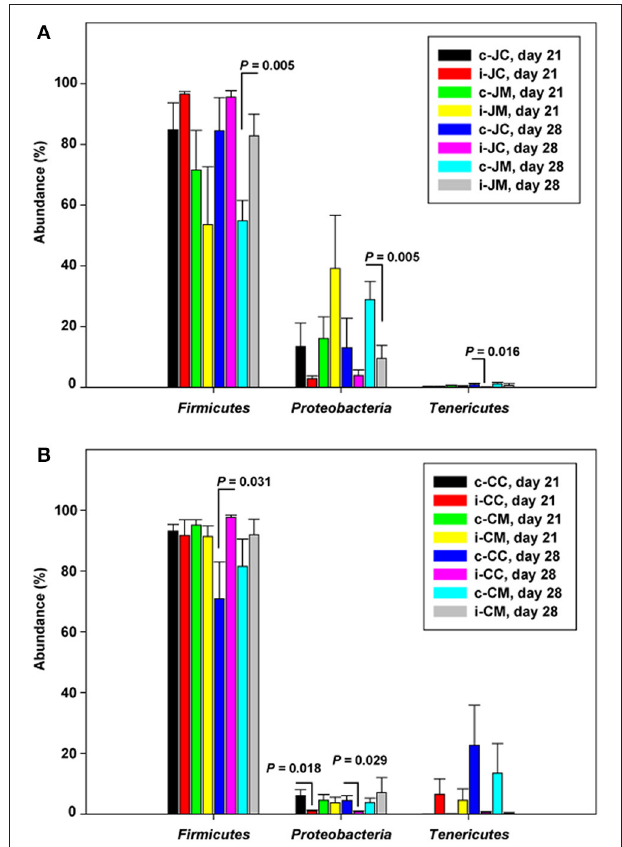
FIGURE 1 | Relative abundances (%) of the most abundant phyla in the infected birds compared with the controls at the two sampling points post infection of (A) jejunum and (B) cecum. Data are presented as the mean values and standard deviation ( SD ). JM, jejunal mucosa; JC, jejunal content; CM, cecum mucosa; CC, cecum content; control (c); infected